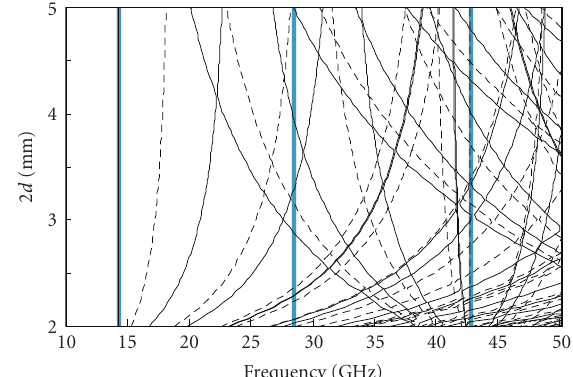
Figure 3: Contour plot of the magnitude of the S 11 parameter at the microstrip port of the antenna.